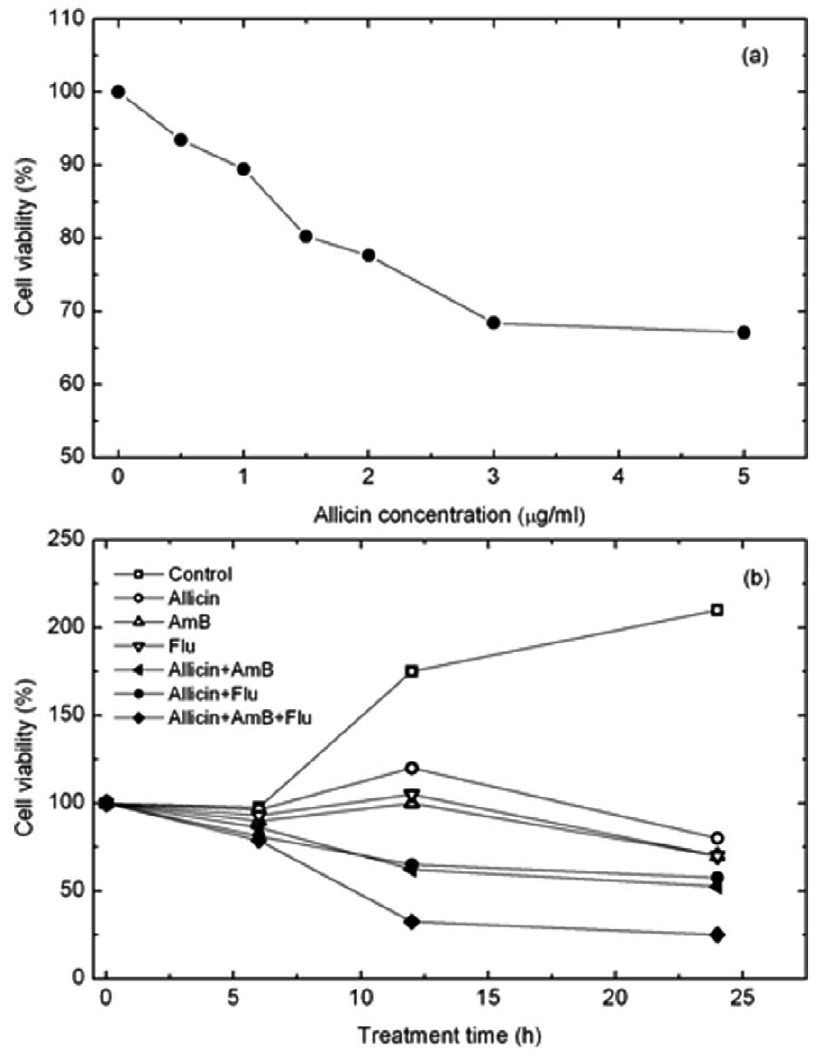
Figure 1. Cell viability of C.albicans treated with allicin and antifungal drugs. (a) The viability of C. albicans as a function of allicin concentration. The concentration of allicin was increased from 0 (control) to 5 m g/mL. (b) Cell viability as a function of treatment conditions. C. albicans cells were treated with allicin alone, one kind of drug (AmB, flucytosine), and the combinations of AmB + allicin, flucytosine + allicin, and AmB + flucytosine + allicin.